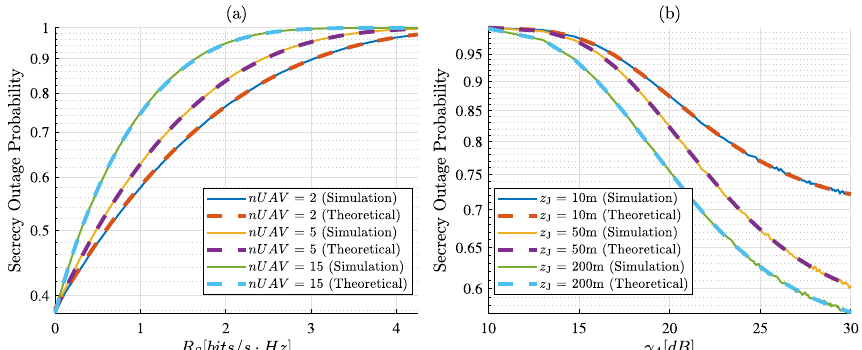
Fig. 5 a SOP over R s values varying the number of UAVs ( nUAV ), b SOP over γ A values varying the common UAV height z